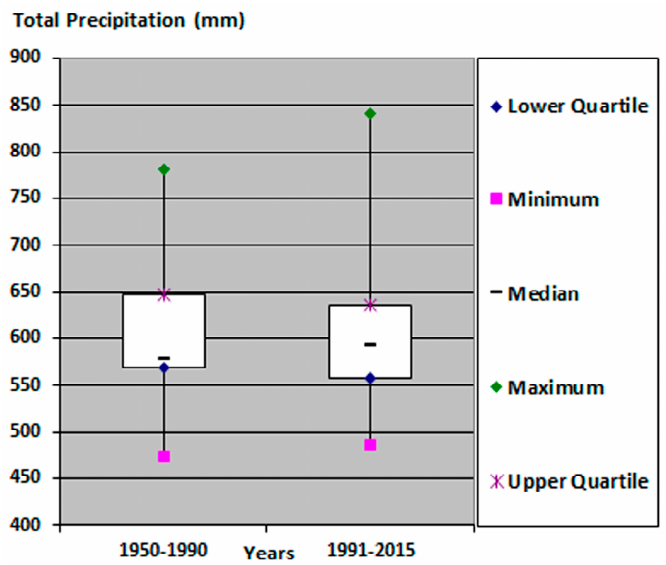
Figure 6. Boxplots showing the variation of relative change in annual precipitation, compared with historical the 1950–1990 and 1991–2015 periods in the Maritsa Basin.